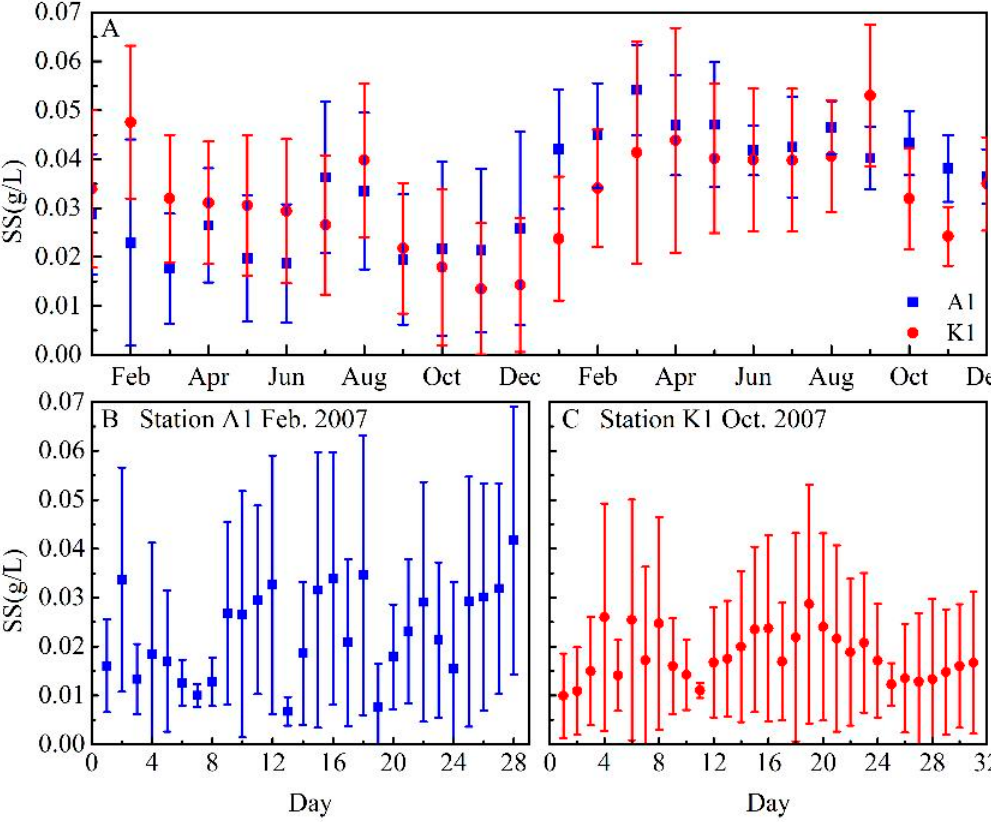
Figure 7. Monthly mean suspended sediment (SS) concentrations (points) and their standard deviations (bars) in 2007 and 2008 at stations A1 and K1 ( A ) and daily mean SS concentrations (points) and their standard deviations (bars) in February 2007 at station A1 ( B ) and in October 2007 at station K1 ( C ).